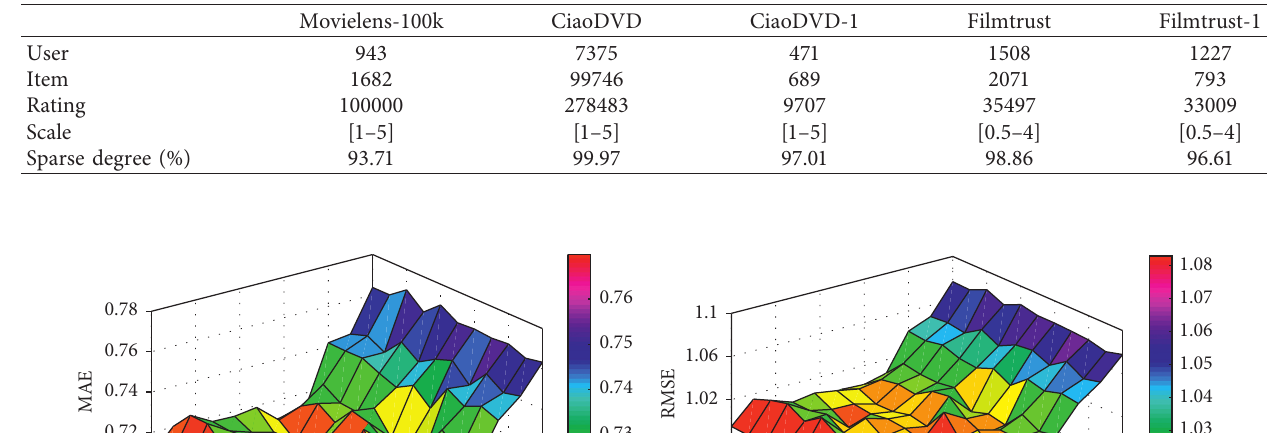
and ε . (b) RMSE results between different values of ε 1 2